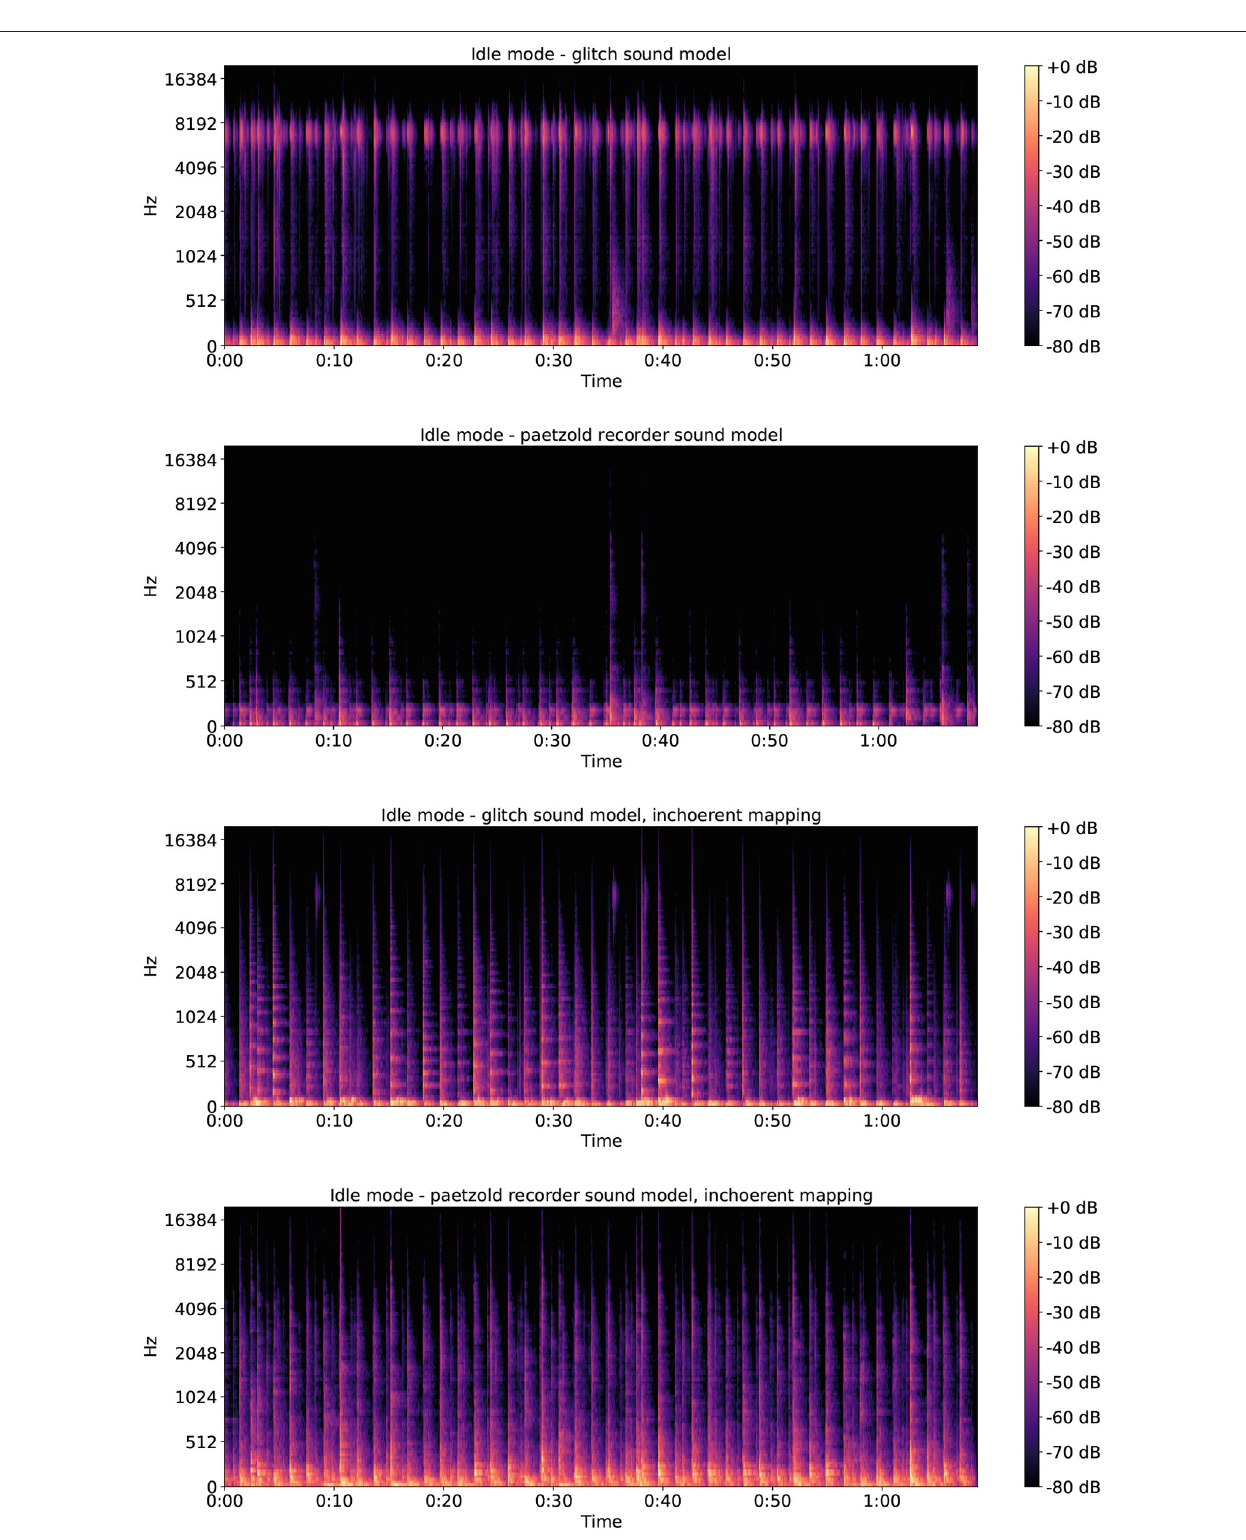
FIGURE 9 | Spectrograms of the four computer idle mode sonifications. From top to bottom: idle mode glitch sound model, idle mode Paetzold recorder sound model, idle mode glitch sound model incoherent mapping, idle mode Paetzold recorder sound model incoherent mapping.